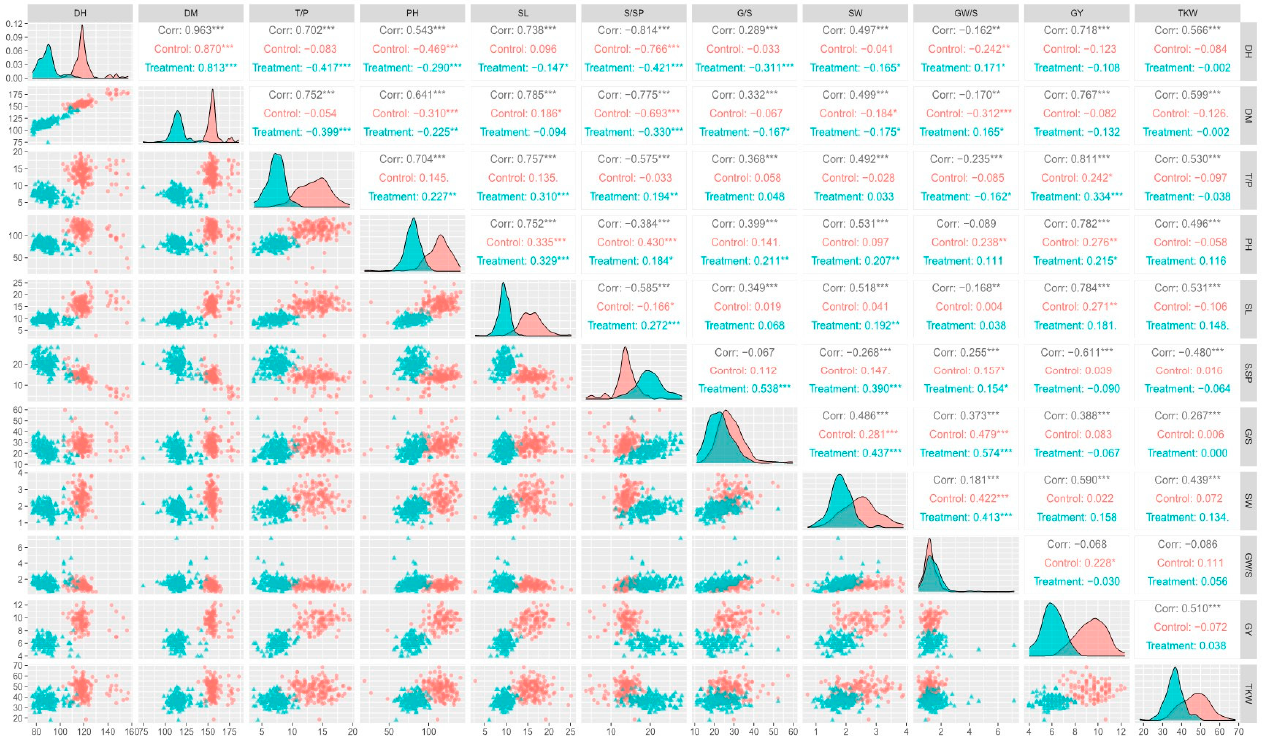
Figure 1. Pearson’s correlation coefficients (r) among multiple traits in control and HS conditions. *,